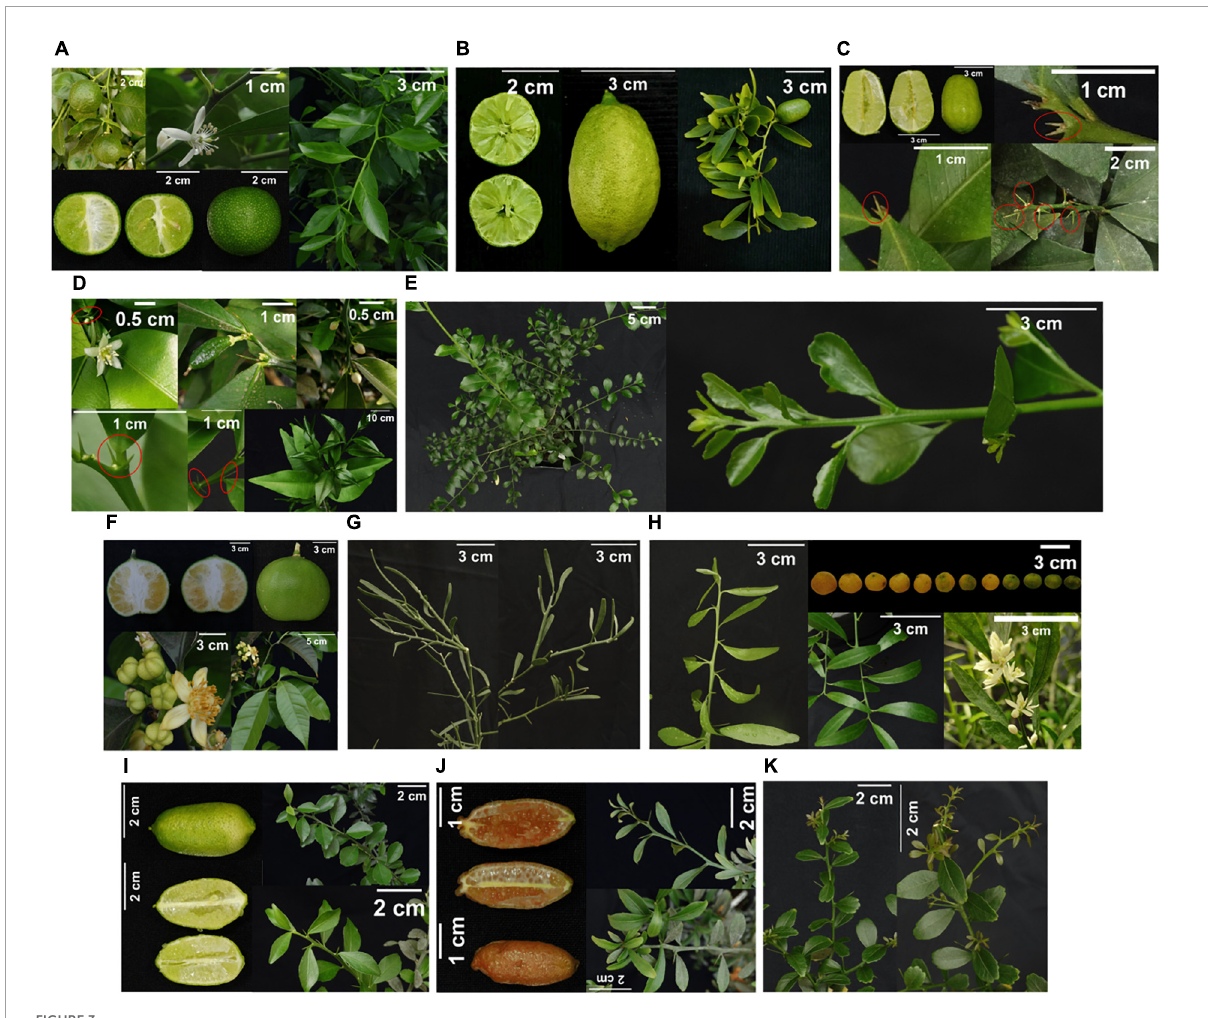
FIGURE3 Morphological characterization of (A) M. warburgiana ; (B) M. papuana × M. warburgiana hybrid; (C) M. australis × M. inodora hybrid; (D) M. inodora ; (E) M. garrawayae; (F) Clymenia polyandra; (G) E. glauca; (H) E. glauca × Citrus sp. hybrid; (I) M . australasica × ( M. australis × M. australasica ) hybrid; (J) [ E. glauca × ( M. australis × M. australasica )] × M. australasica hybrid; and (K) M.